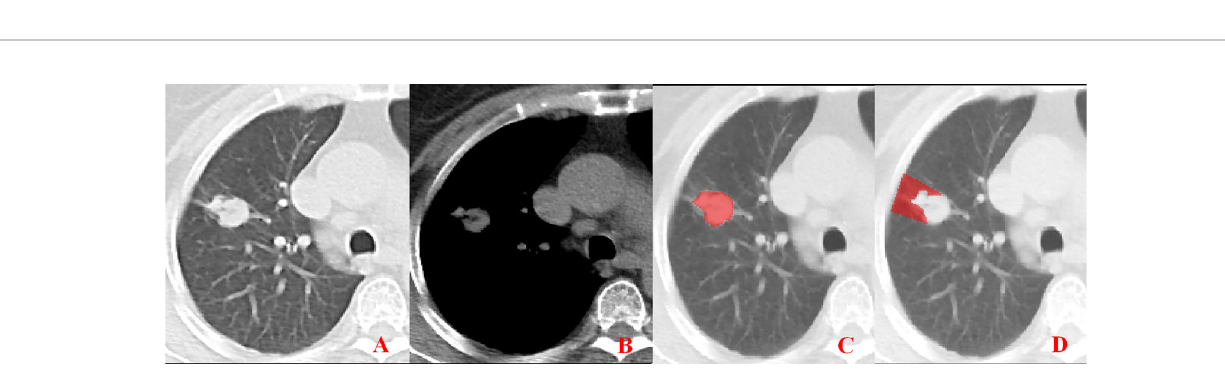
FIGURE 2 | Pleural involvement of Type I. (A, B) One or more linear shadows are observed between the tumor and pleura in the lung window images but are not observed in the mediastinal window images. (C, D) ROI delineation of the primary tumor and nearby